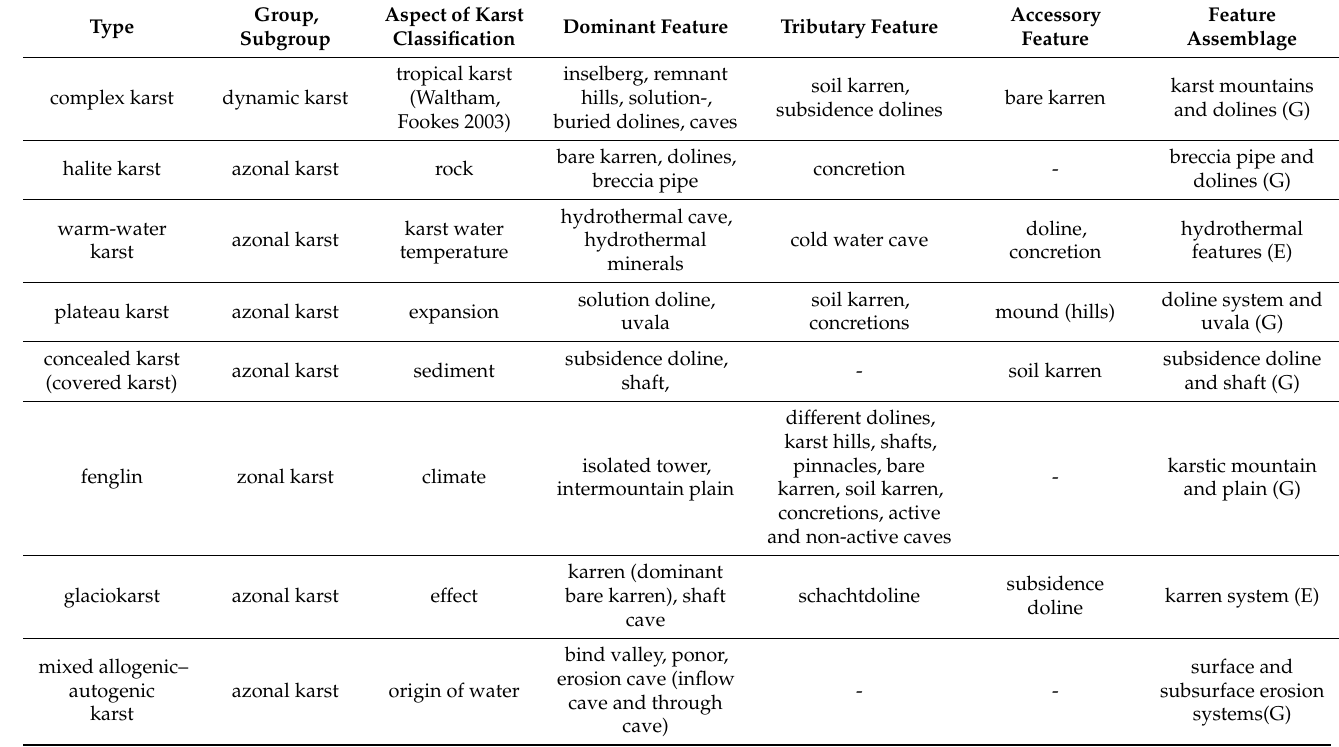
Table 2. Features and feature assemblages of various karst